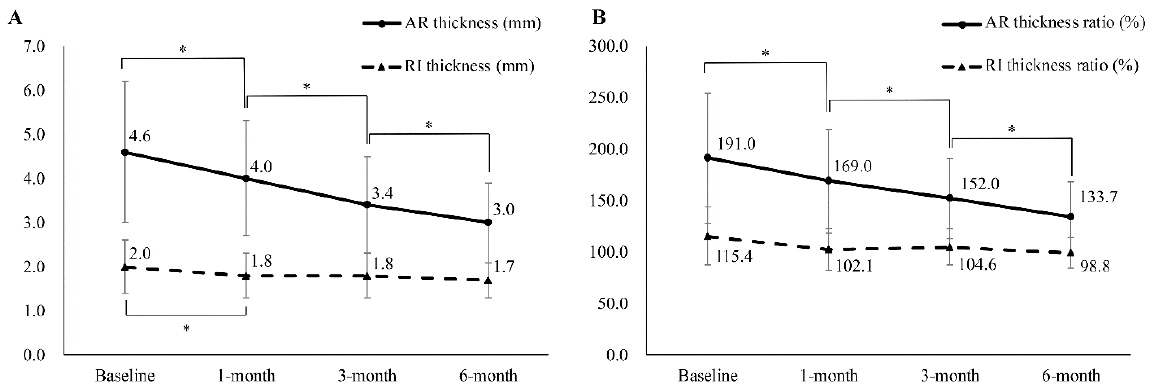
Figure 4. ( A ) Sequential changes in the ultrasound parameters of patients with adhesive capsulitis. ( B ) Sequential changes of ratio of ultrasound parameters in the same population. The ratio between the thicknesses of the RI and the AR of the affected and unaffected shoulders was calculated by dividing the value of the affected shoulder by that of the unaffected shoulder and was converted into a percentage score. AR, axillary recess; RI, rotator interval. * Significantly different from previous evaluation.